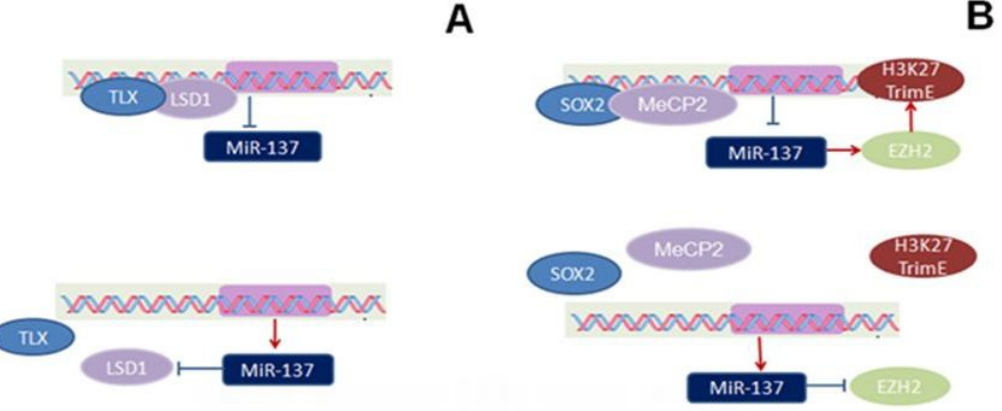
Figure 1. Expression regulation of miR-137. ( A ) In embryonic NSCs, TLX represses the expression of miR-137 by recruiting LSD1 to the genomic regions of miR-137. On the other hand, miR-137 suppresses LSD1 expression to inhibit its binding to TLX. Therefore, miR-137 forms a negative feedback regulatory loop with TLX and LSD1 to ensure its expression is maintained at an appropriate level; ( B ) In aNSCs, MeCP2 along with Sox2 mediates the epigenetic regulation of miR-137. One target of miR-137, Ezh2, is a histone H3 lysine 27 methyltransferase. The miR-137–mediated repression of Ezh2 feeds back to chromatin, resulting in a global decrease in histone H3 trimethyl lysine